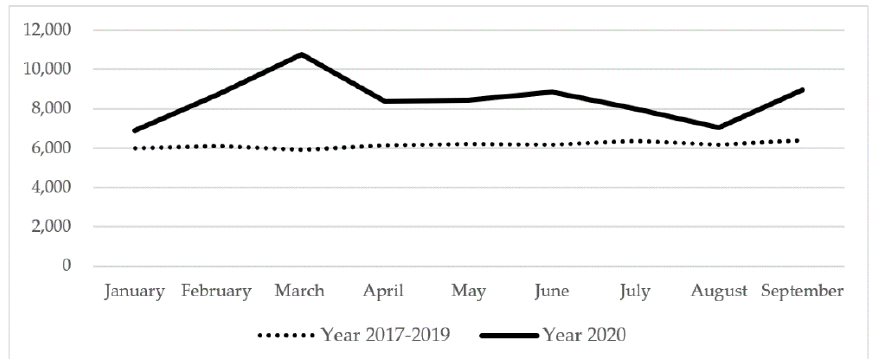
Figure 1. Monthly average farmland prices over time. Note: the Y-axis is farmland price (TWD/m 2 ), and the X-axis is an indicator of month. Data are drawn from the Actual Price Registration System managed by the Ministry of Interior in Taiwan. The years of 2017 to 2019 report the average values of farmland prices for these three years, while the year of 2020 reports the averages for 2020.